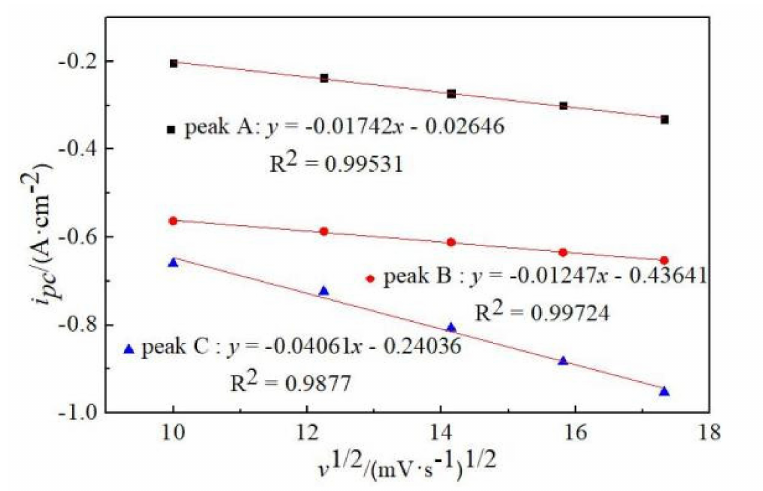
Figure 5. ZnFe 2 O 4 coated Mo electrode i pc and v 1/2 relationship curve.